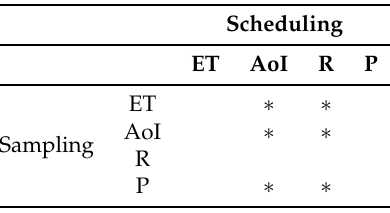
Table 1. Considered combinations of sampling/scheduling policies. The combinations designated with ∗ are discussed either analytically or in